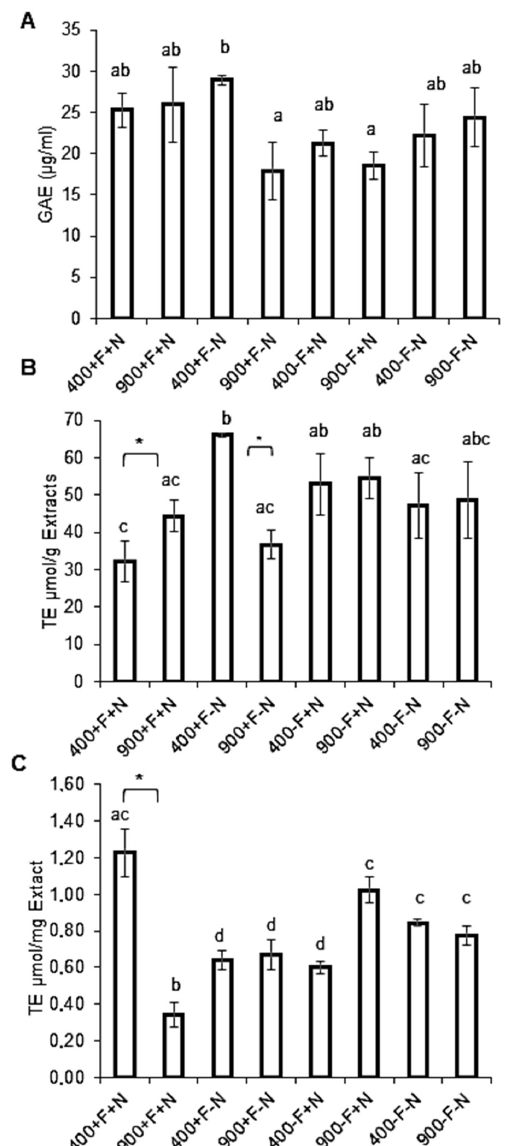
Figure 4. Antioxidant activity of Micro-Tom tomato fruits extracts. Fruits samples were collected from hydroponically grown plants under ambient (400 ppm) or elevated (900 ppm) atmospheric CO 2 concentrations with four nutritional regimes: control (+F/+N), iron deficiency ( − F/+N), nitrogen deficiency (+F/ − N) or dual deficiency ( − F/ − N). ( A ) Total polyphenol content (Folin – Ciocalteu method), ( B ) 2,2-diphenyl-1-picrylhydrazyle (DPPH) assay, ( C ) Oxygen radical absorbance capacity (ORAC) assays. Error bars show ±SD ( n = 3). T -test significance: *, p < 0.05. Means within each condition with the same letter are not statistically different according to one-way ANOVA followed by post hoc Tukey test ( p < 0.05).